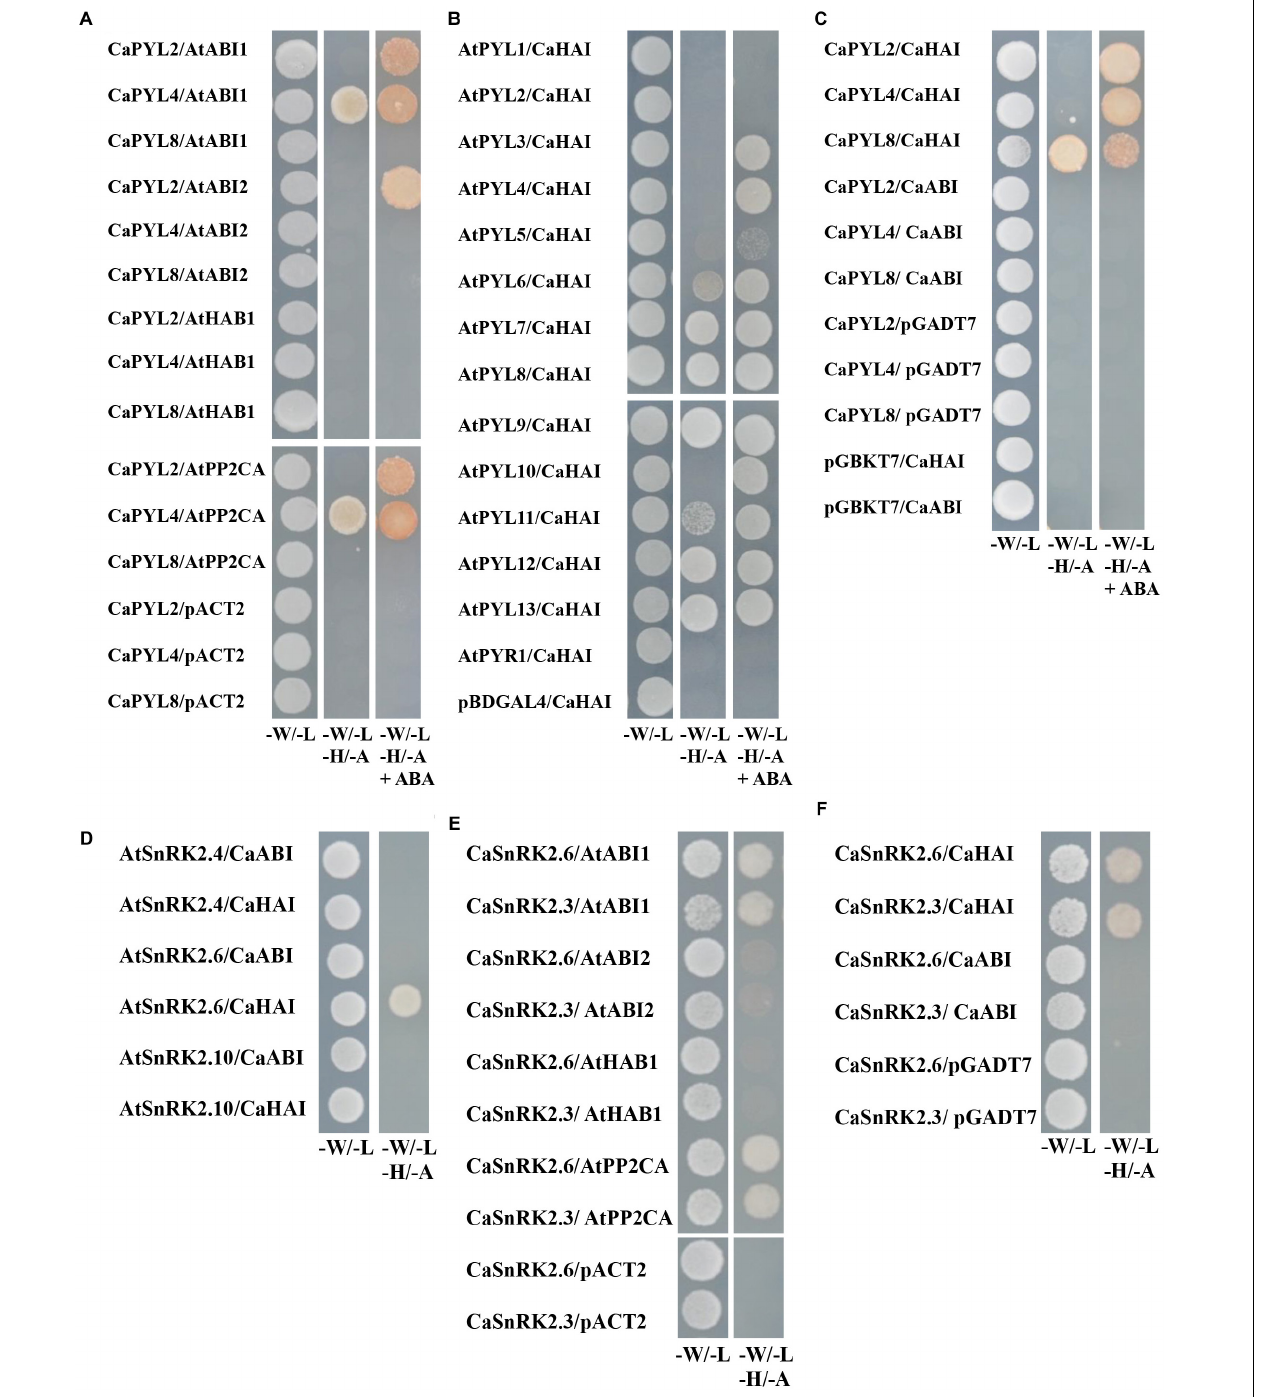
Frontiers in Plant Science |